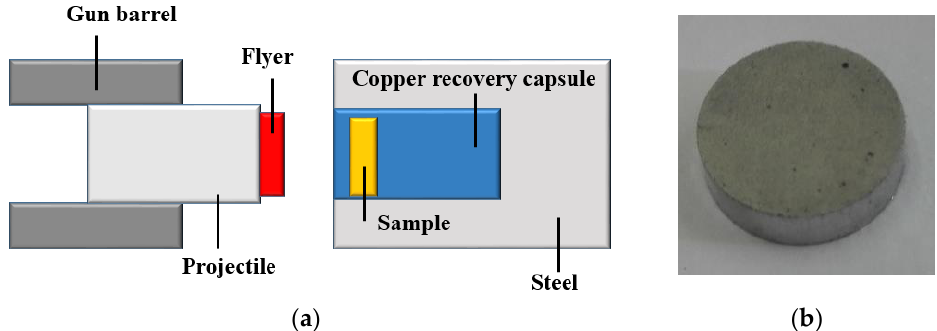
Figure 1. Schematic of the reaction chamber connected to the part of light-gas gun ( a ), sample ( b ) [17].